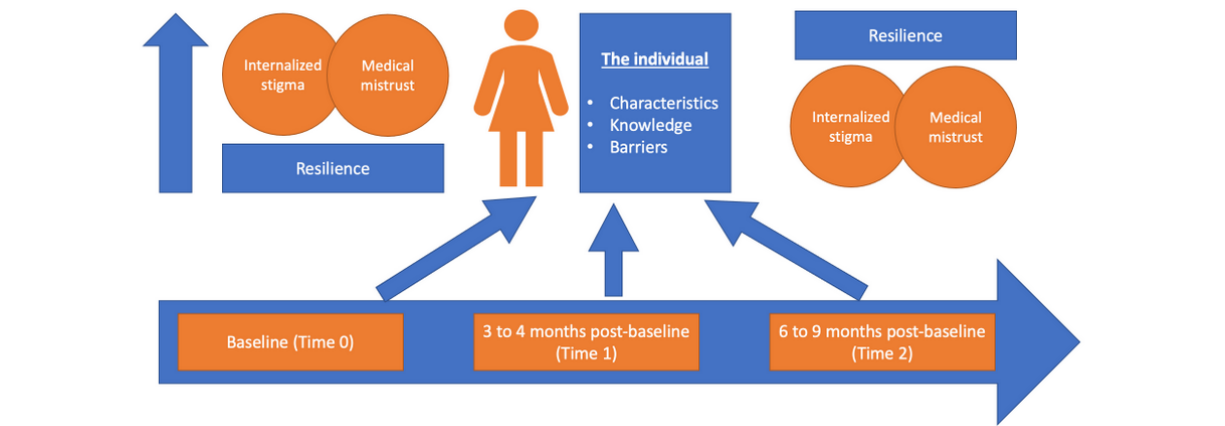
Figure 1. Protocol conceptual framework based on the Health Belief